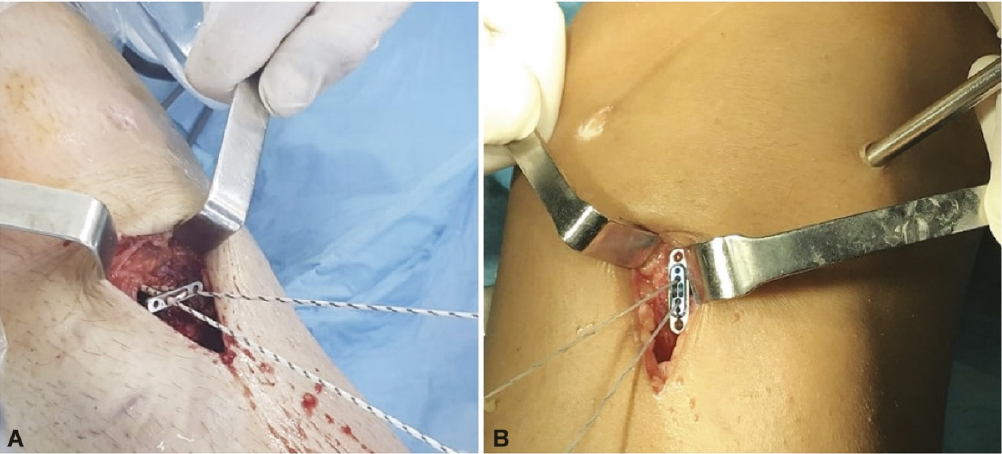
Figure 2. The graft was fixed to the tibial side with a suspended large button. ( A ) The graft was fixed to the tibial side with a Lift Loop. ( B ) The graft was fixed to the tibial side with an Ultrabutton plus Xtendobutton combination.